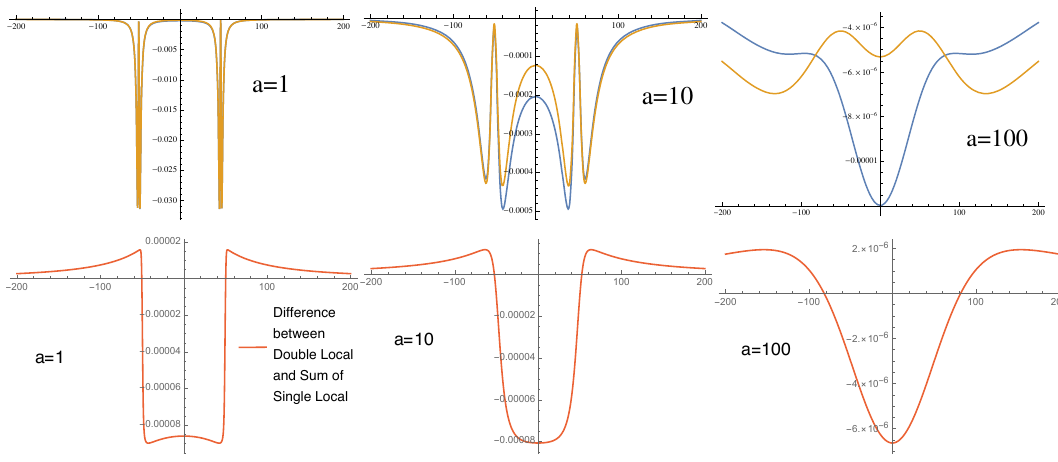
Figure 27 . Top: the behaviors of entanglement entropy at t = 0 in Dirac Fermion CFT for the double joining local quench (blue) and the sum of two single local quenches (orange) at a = 1 (left), a = 10 (middle) and a = 100 (right). We chose the subsystem A to be A = [ x